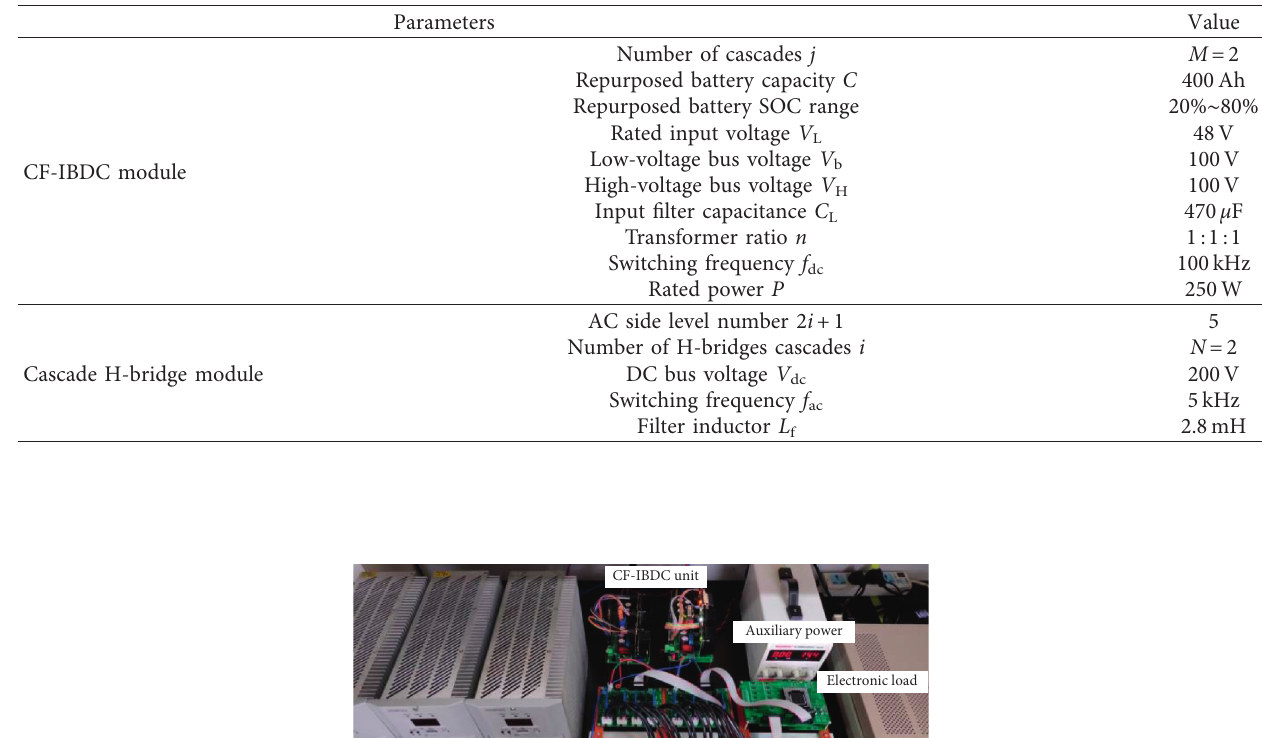
Table 3: Simulation model and experimental platform parameters.